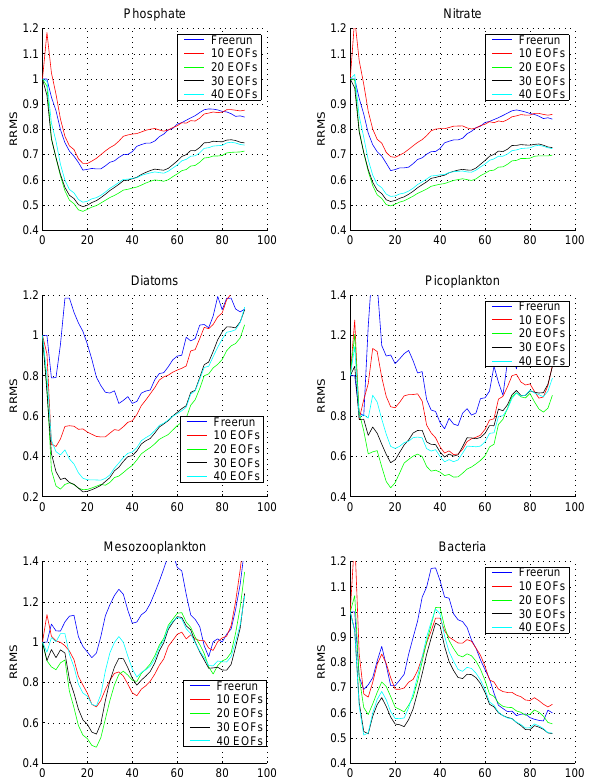
Fig. 5. Evolution in time of phosphate, nitrate, diatoms, picoplank- ton, mesozooplankton and bacteria RRMS from the model free-run and the SFEK filter assimilating profiles with 10, 20, 30 and 40